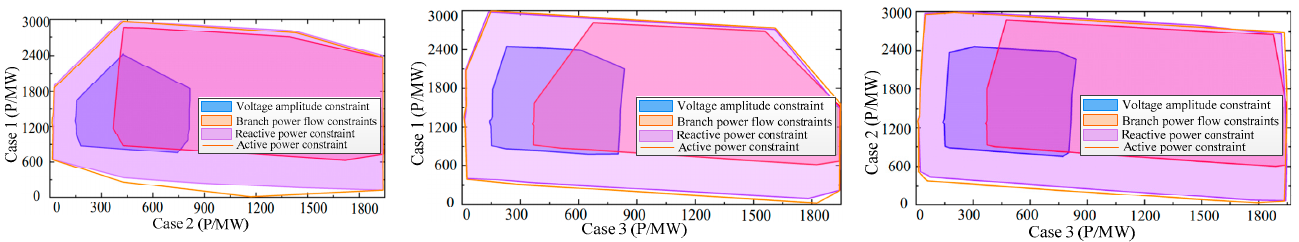
Figure 11. Two-dimensional SSR constructed by the IPSO-RLS hybrid algorithm (Case 1: Santanghu station; Case 2: Hami station; Case 3: Yandun station).